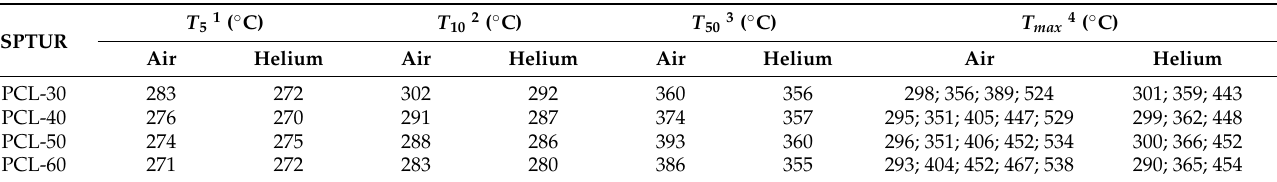
Table 4. TG data of the synthesized SPTURs.